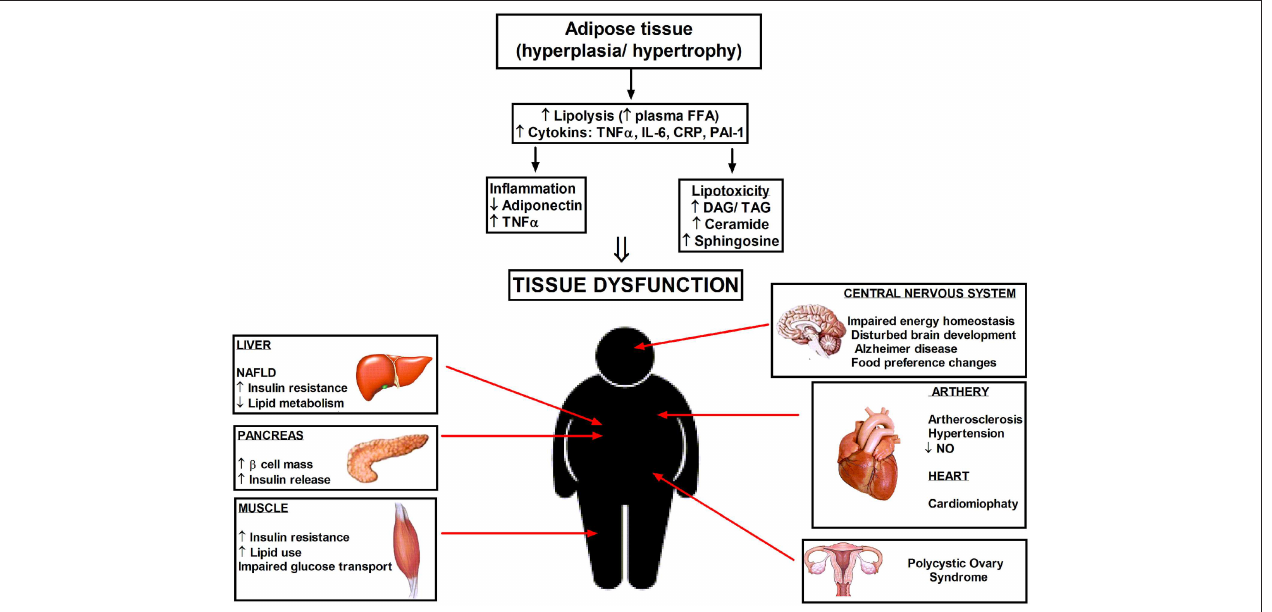
FIGURE 1 | Hyperplasia and hypertrophy of adipose tissue cause systemic inflammation and lipotoxicity due to elevated cytokines and accumulation of lipid metabolites in the tissues not suited for fat storage. Increased ceramide level in enlarged adipocytes elicit the pathophysiological disturbances in different tissues and organs. DAG, diacylglycerol; TAG, triacylglycerol; NAFLD, nonalcoholic fatty liver